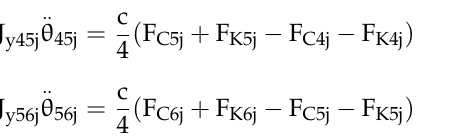
Figure 2. Suspension model of the semi-trailer using the leaf spring.